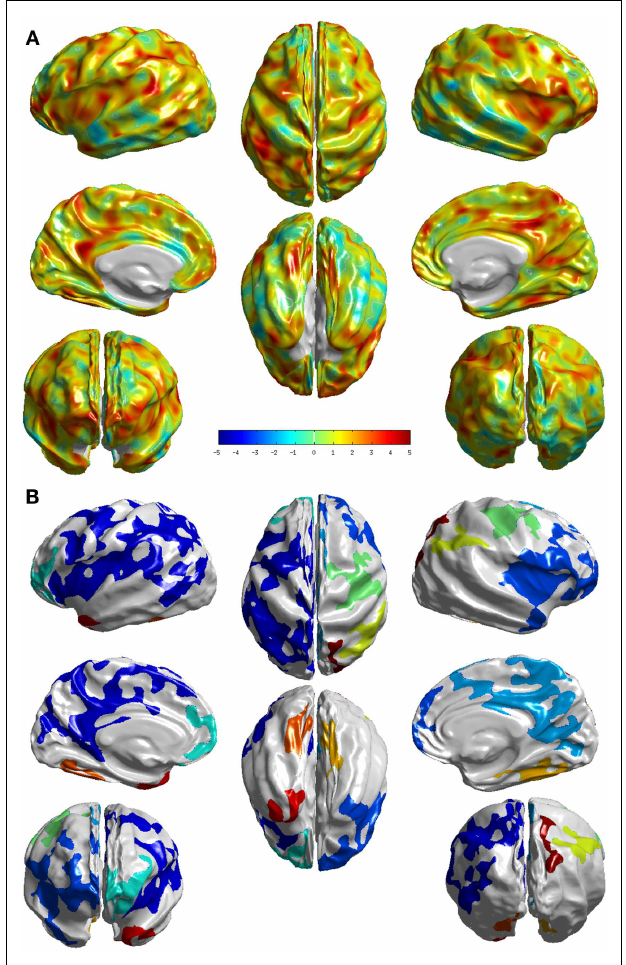
FIGURE 2 |Visualization of the differences between the two groups NC and sd-aMCI . (A) T -statistic values displayed at each vertex (B) the set of clusters, which survived the multiple-comparisons test (cluster-wise significance), each colored differently.We can see that significant differences exist, although in few localized cortical areas.